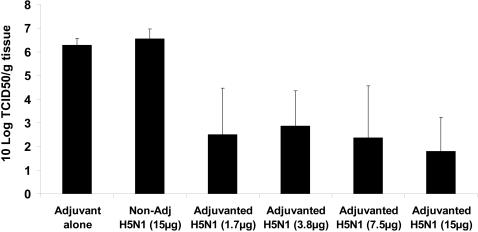
A/H5N1 viral load in the lung: